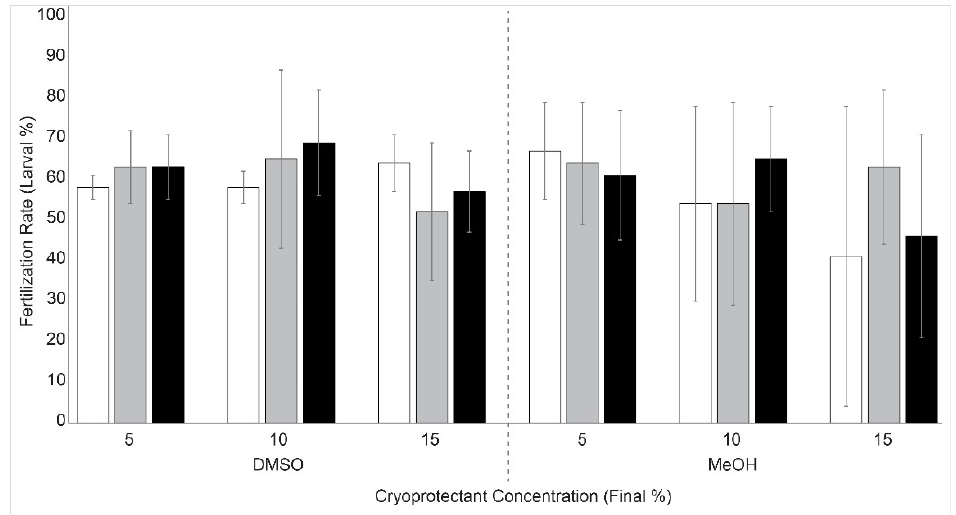
Figure 4. Fertilization rate of Hydractinia by use of sperm cryopreserved with different cryoprotectants and cooling rates ( n = 3). Fertilization rate is reported as mean (±SD) percentage calculated by dividing the number of larvae by the initial number of eggs. White bars represent cooling at 5 °C/min, grey bars represent cooling at 10 °C/min cooling, and black bars represent cooling at 15 °C/min. DMSO: dimethyl sulfoxide; MeOH: methanol.